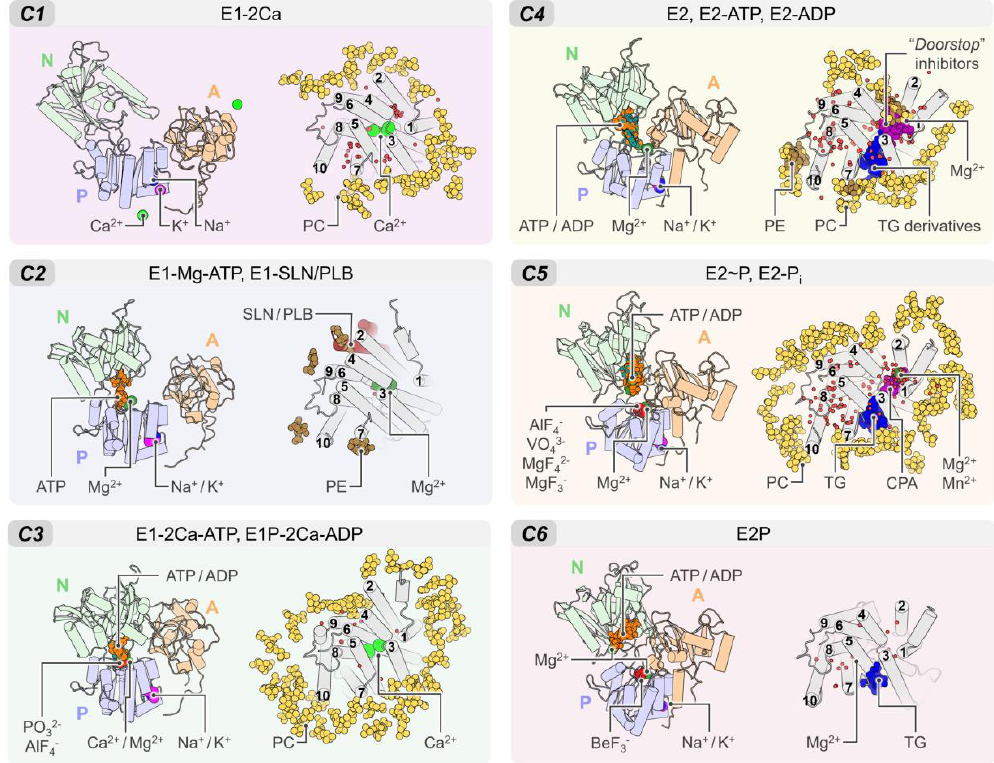
Figure 5. Summary of the binding sites located in the cytosolic and TM domains of SERCA. We show the cytosolic and transmembrane regions of SERCA bound to ions, lipids, small molecules, regulatory review. In all panels, the TM domain is shown from the cytosolic space in the membrane